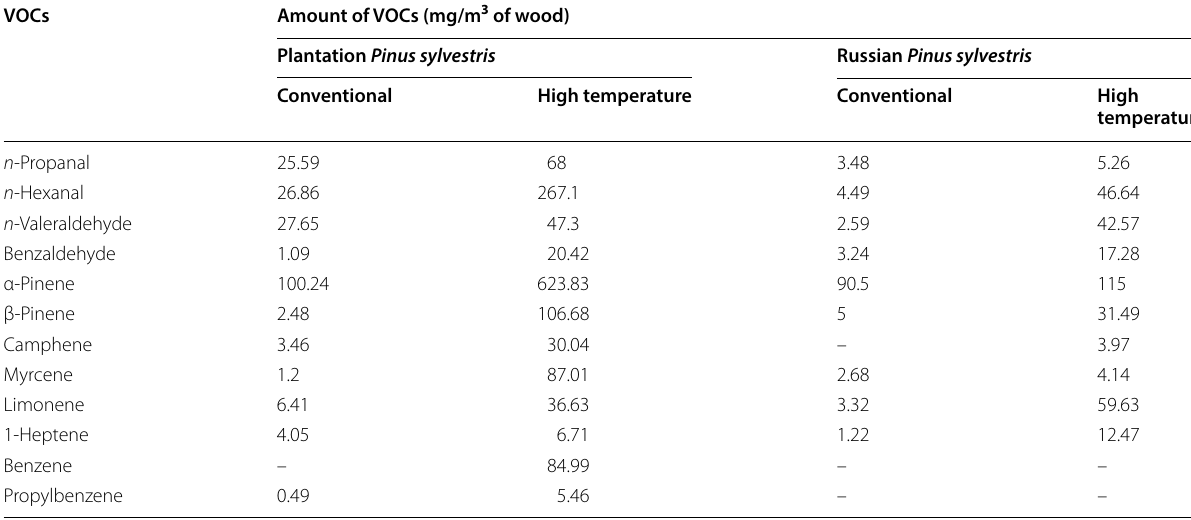
Table 6 Total amount of primary VOCs released per m 3 of wood during conventional and high-temperature